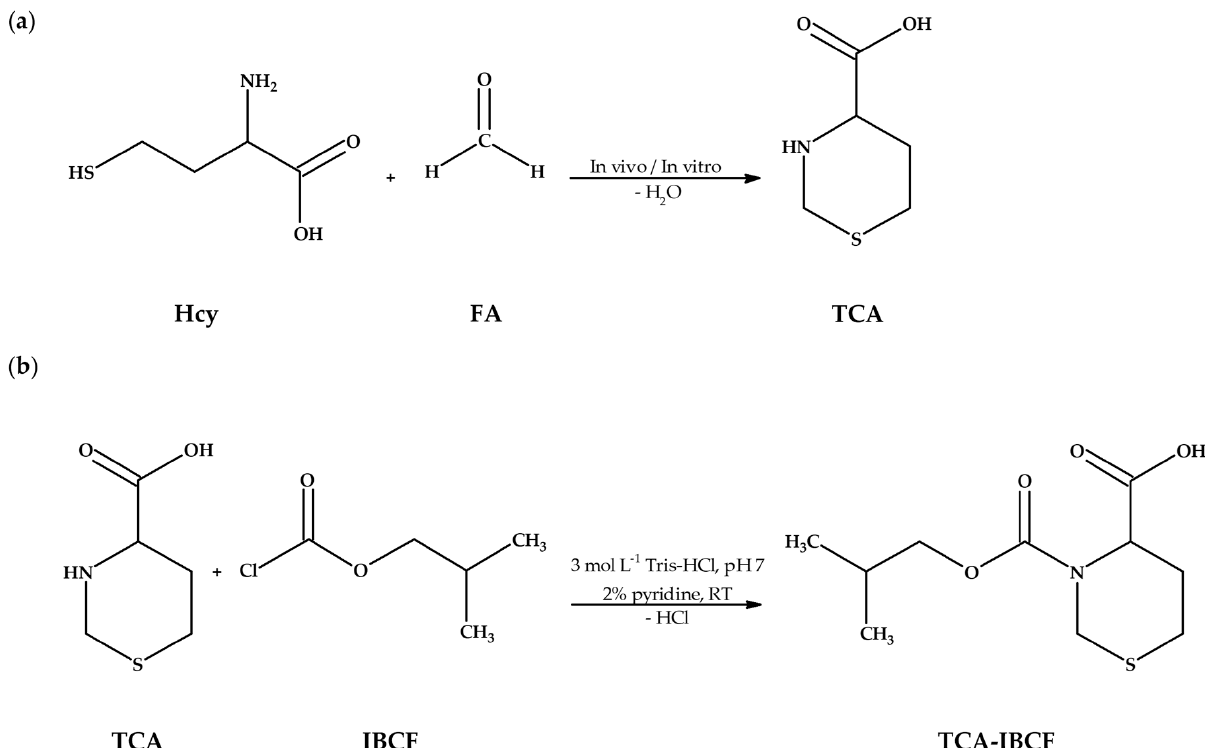
Figure 1. Research project objectives. ( a ) The reaction equation of homocysteine (Hcy) with formaldehyde (FA) providing 1,3-thiazinane-4-carboxylic acid (TCA); ( b ) The chemical derivatization reaction of TCA with isobutyl chloroformate (IBCF) in the presence of pyridine, resulting in formation of an isobutyl derivative of TCA (TCA-IBCF). Abbreviations: FA, formaldehyde; Hcy, homocysteine; IBCF, isobutyl chloroformate; RT, room temperature; TCA, 1,3-thiazinane-4-carboxylic acid; TCA-IBCF, isobutyl derivative of 1,3-thiazinane-4-carboxylic acid; Tris-HCl, tris(hydroxymethyl)aminomethane-hydrochloride acid